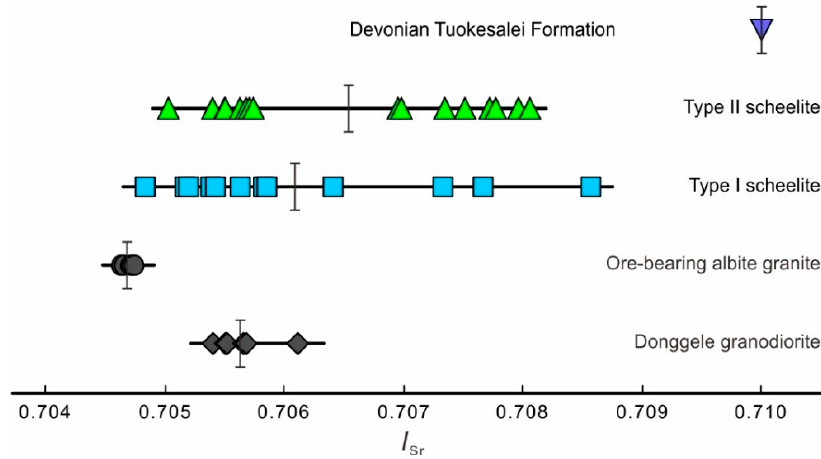
Figure 5. The I Sr (t) plot for the Doranasai gold deposit and related